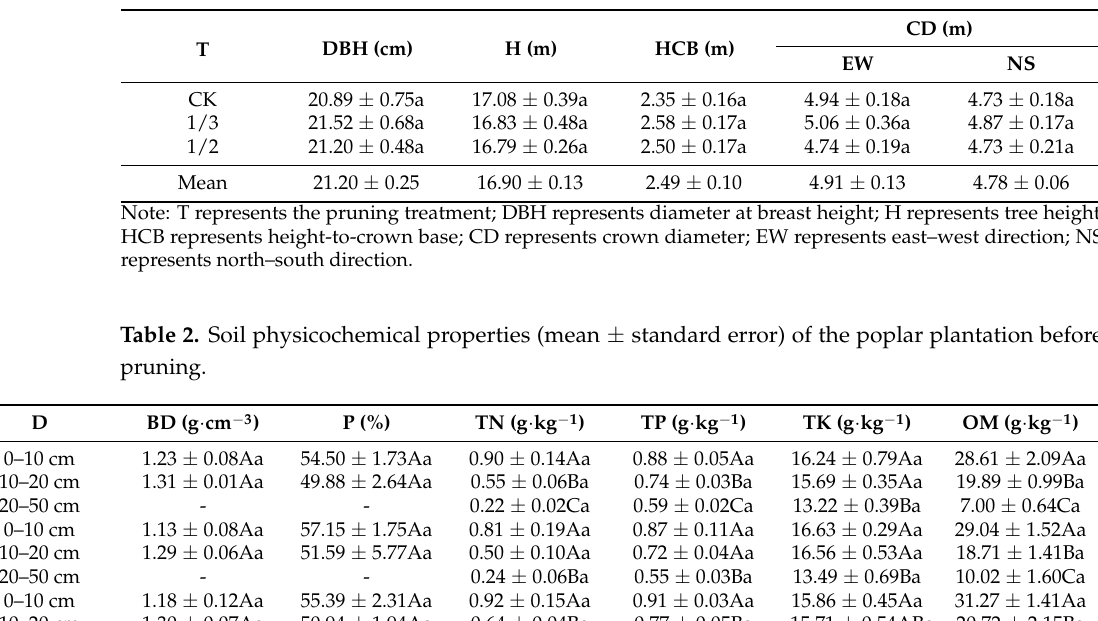
Table 1. Main stand characteristics (mean ± standard error) of the poplar plantation before pruning.